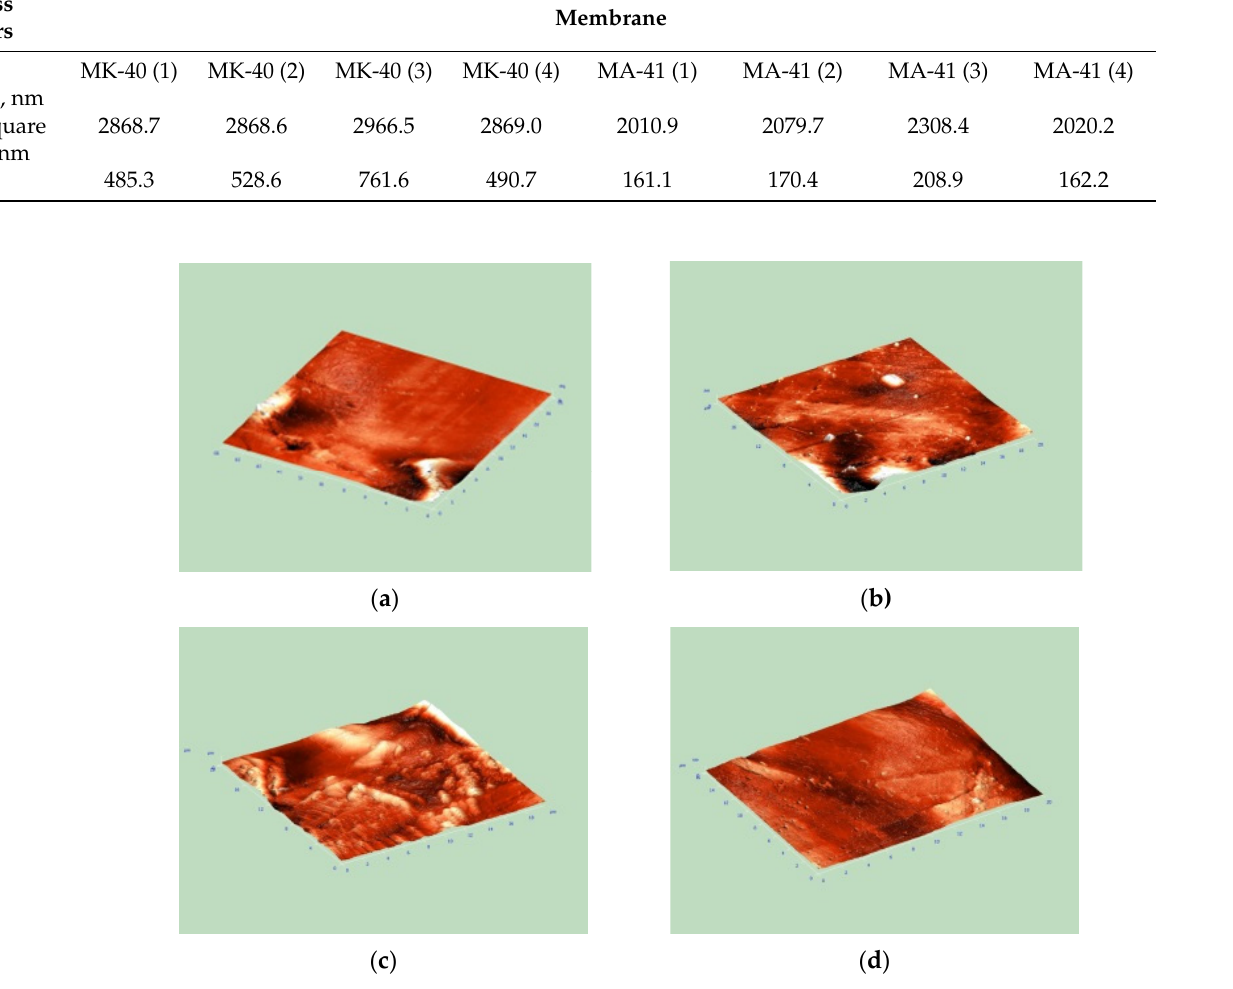
Figure 3. Three-dimensional images of the surface of the MA-41 membrane: ( a ) OH − -form, ( b ) Pro- form, ( c ) membrane after prolonged contact with solution containing Pro during electrodialysis, ( d ) membrane after regeneration (Scanned field—(20 × 20) × 1.6 μ m). Table 3. Roughness parameters of the ion-exchange membranes in different forms: H + -form of MK-40 and OH − -form of MA-41 (1), Pro-form (2), fouled membrane during electrodialysis of Pro containing solution (3), regenerated membrane (4).